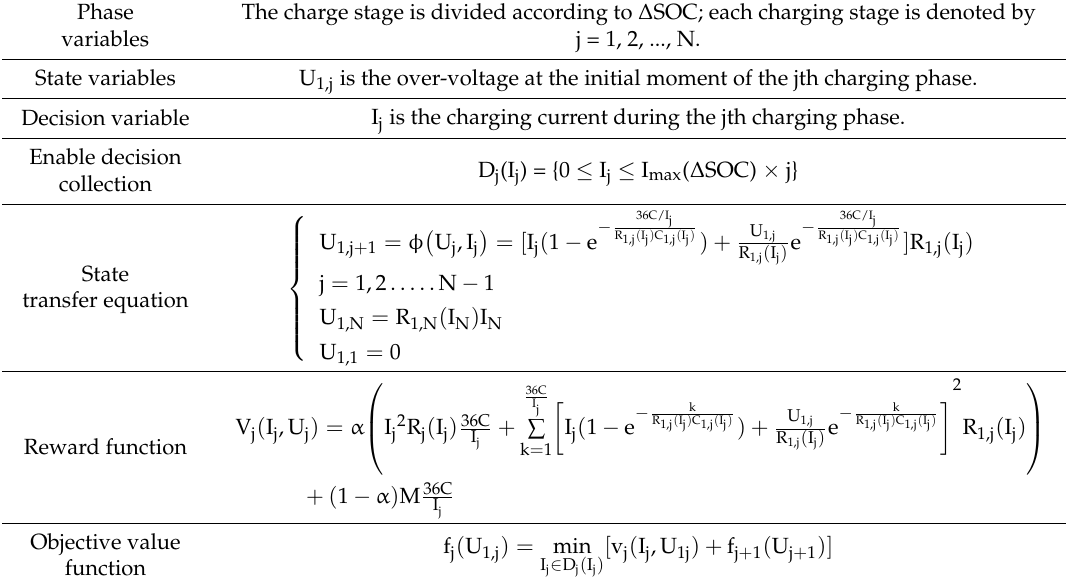
Table 2. Mathematical model of dynamic programming